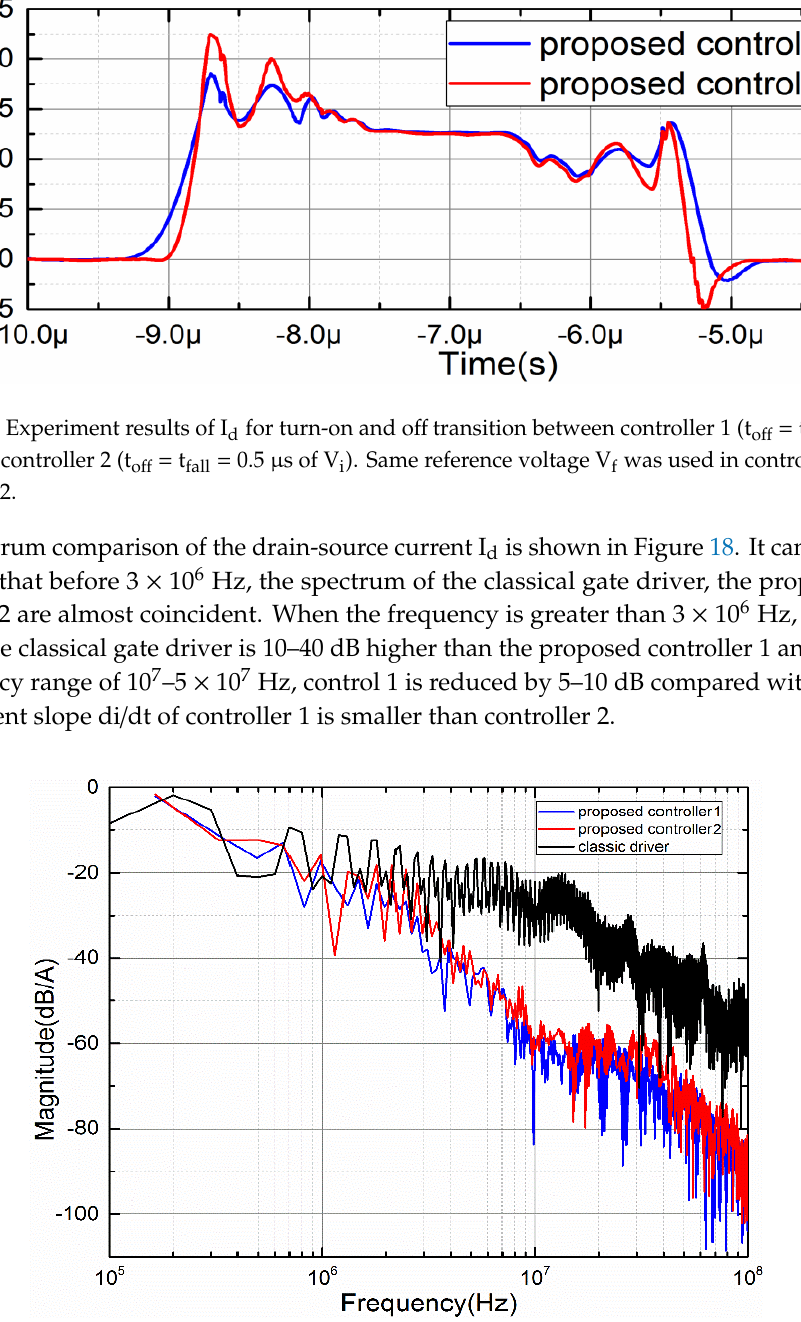
and proposed controller 2 (red). Same reference voltage V f was used in controller 1 and controller 2.